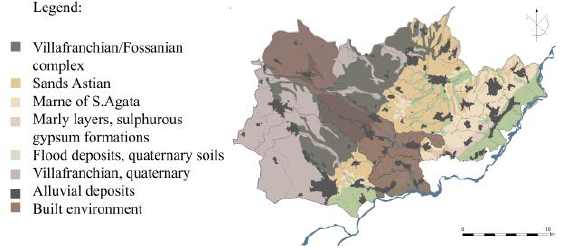
Figure 3. Study Area, Geomorphological Map, reworking of the authors.